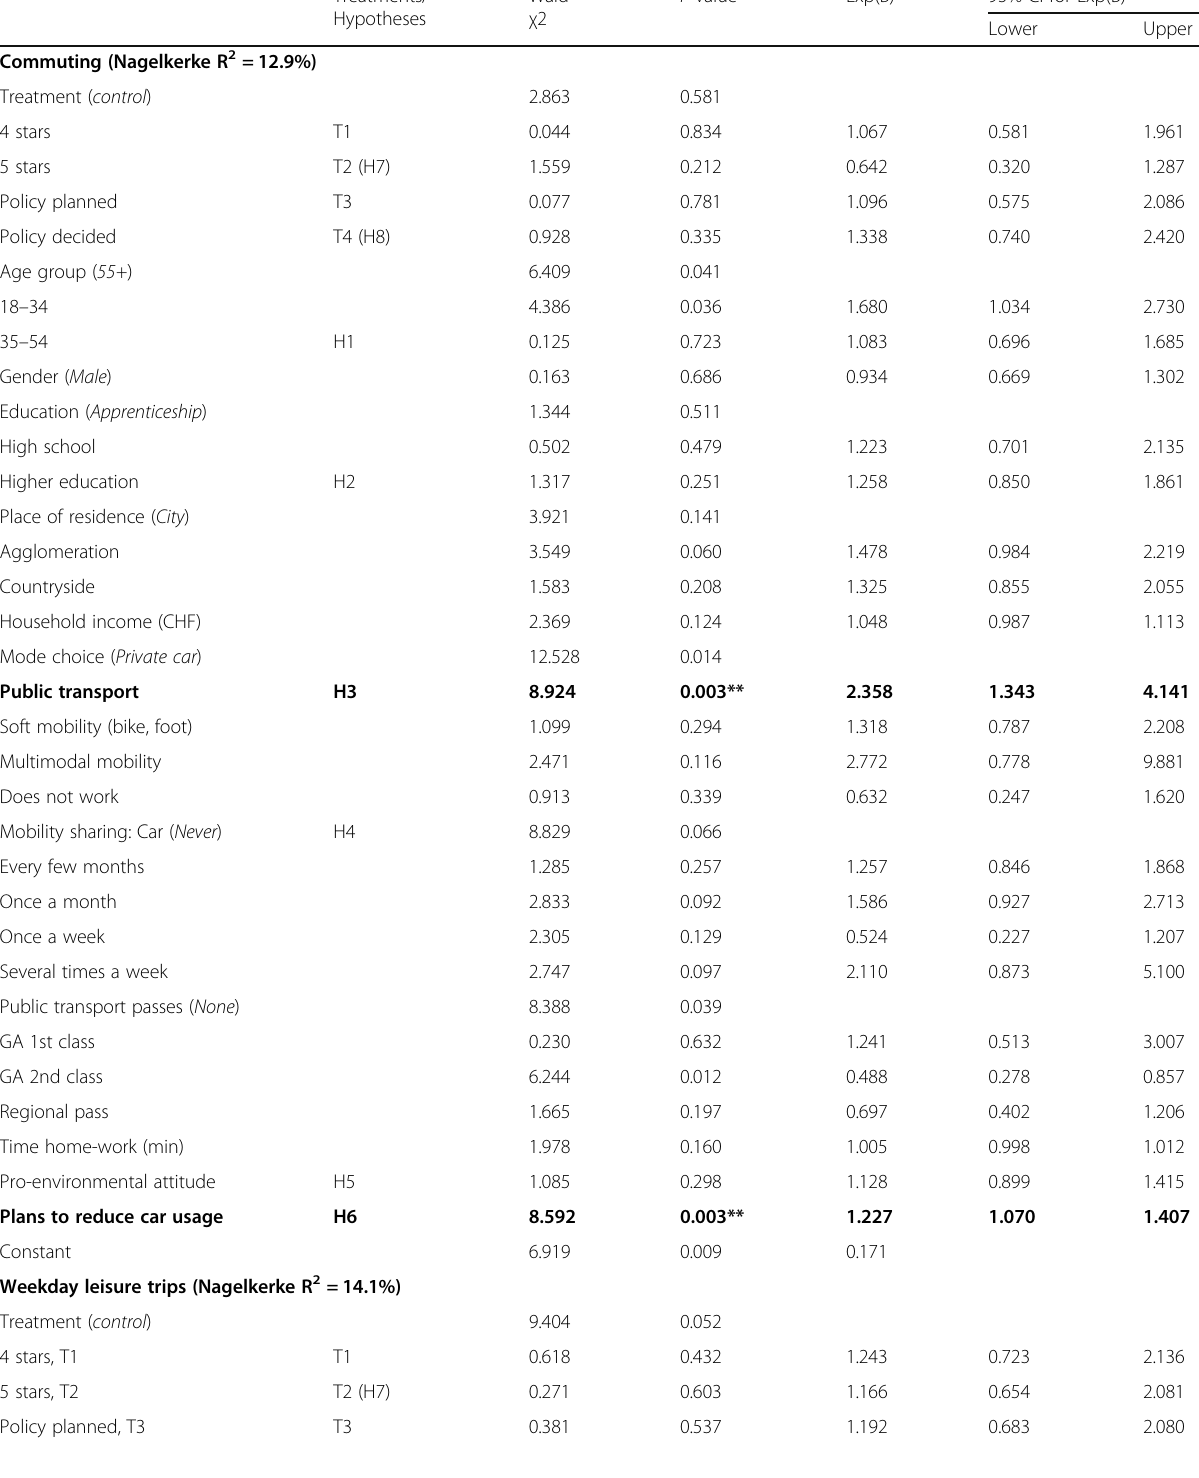
Table 4 Results of the binary logistic